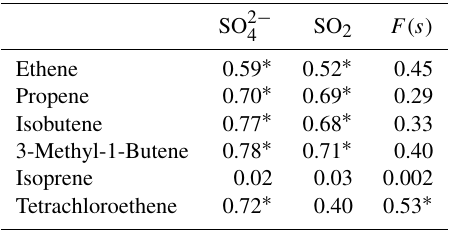
Table A2. Correlation coefficients ( r ) between SO 2 , sulfate, and alkenes with concentrations higher than the detection limit. P values < 0.05 are indicated with a ∗ .